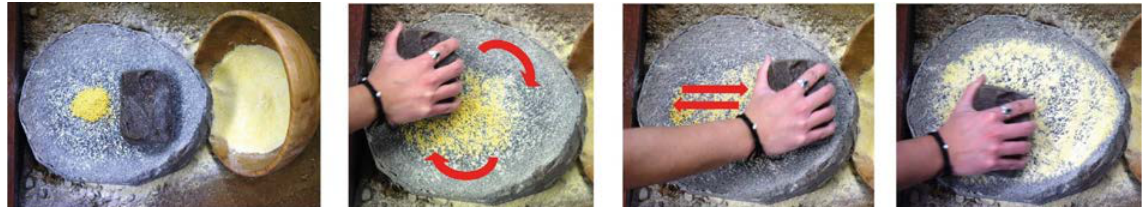
Figure 8. Experimental sequences. Experiment 2 grinding of millet with andesite type A3.